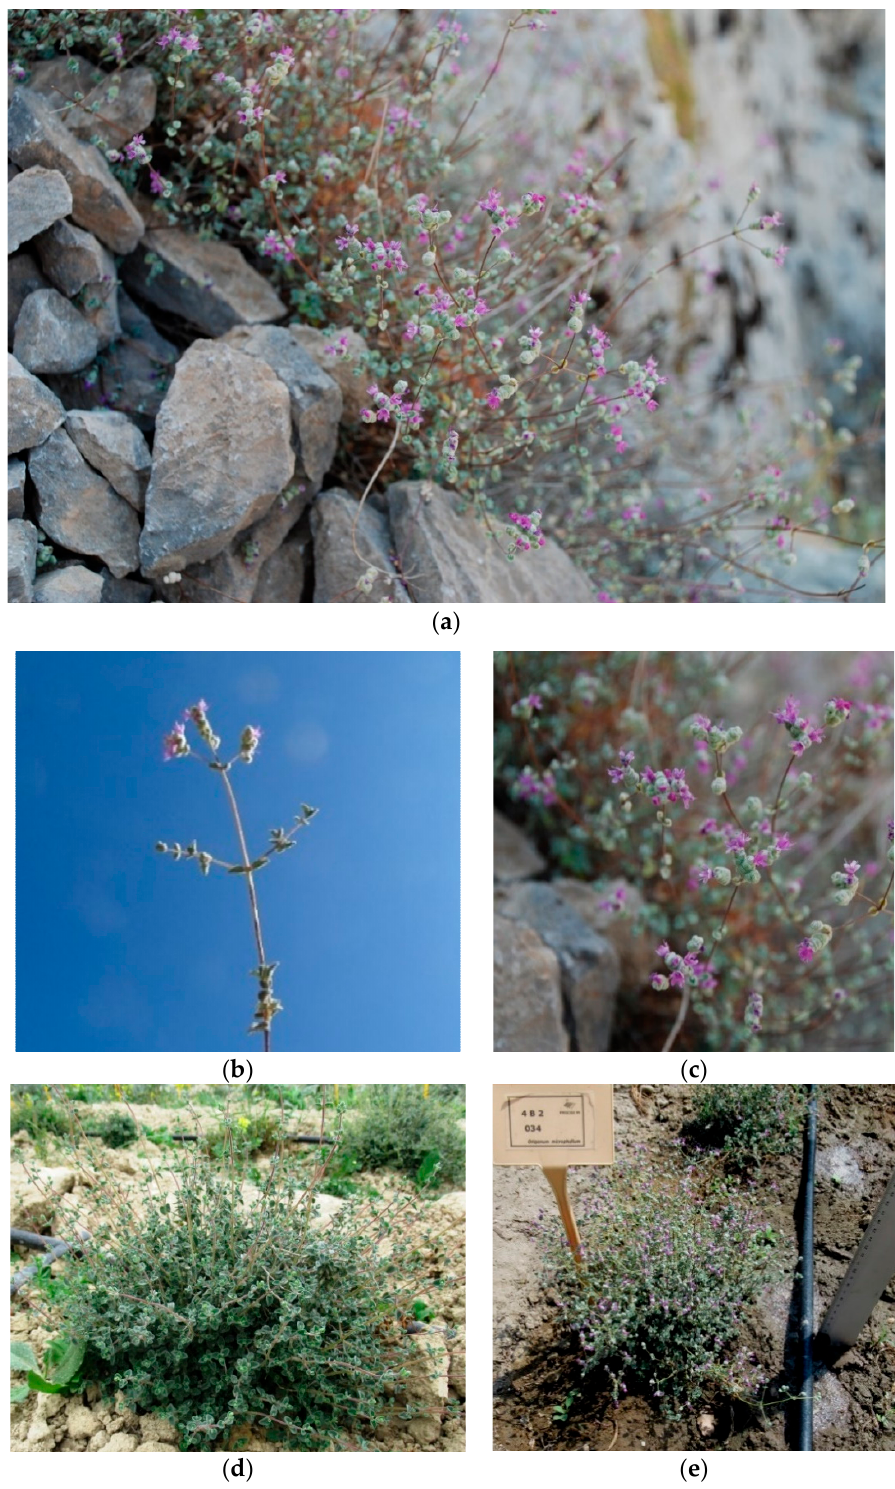
Figure 1. The Critically Endangered local endemic of Crete Origanum microphyllum (Cretan marjo- ram): ( a ) in its wild rocky habitat in Samaria gorge, Crete; ( b ) with flowering shoots bearing small leaves; ( c ) with densely hairy verticillasters with violet corollas; ( d,e ) at vegetative and early flowering stage in its pilot cultivation area (campus of the Hellenic Mediterranean University in Heraklion, Crete).